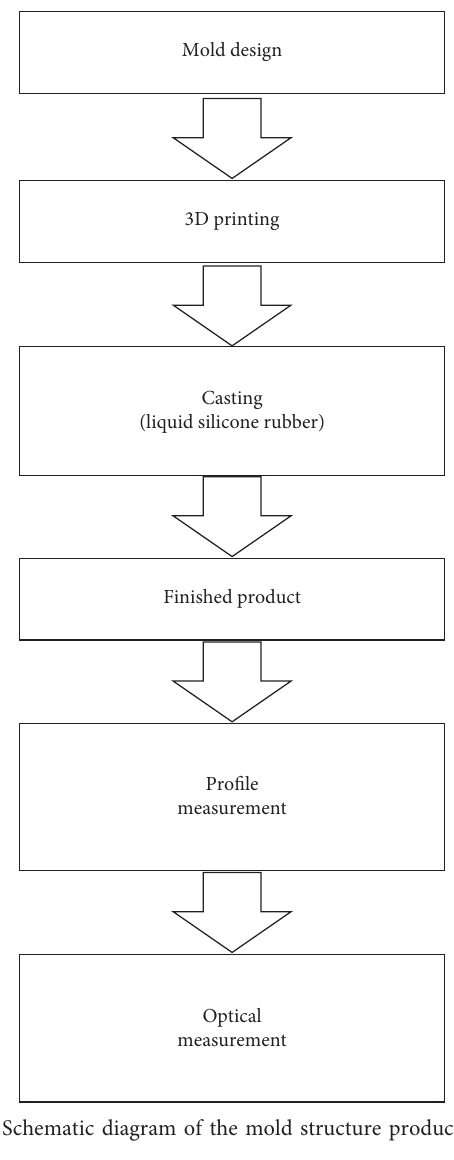
Figure 14: Schematic diagram of the mold structure production process.